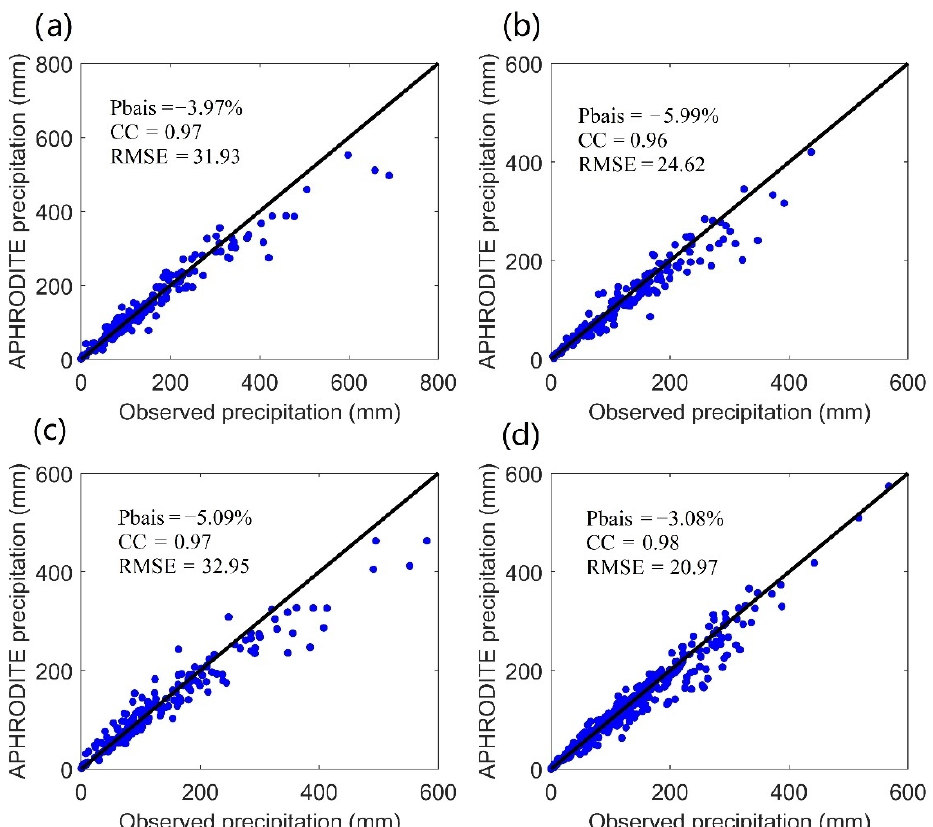
Figure 3. Scatter plot of ( a ) QZ, ( b ) JH, ( c ) LX, and ( d ) WR stations APHRODITE rainfall products compared to the measured rainfall.